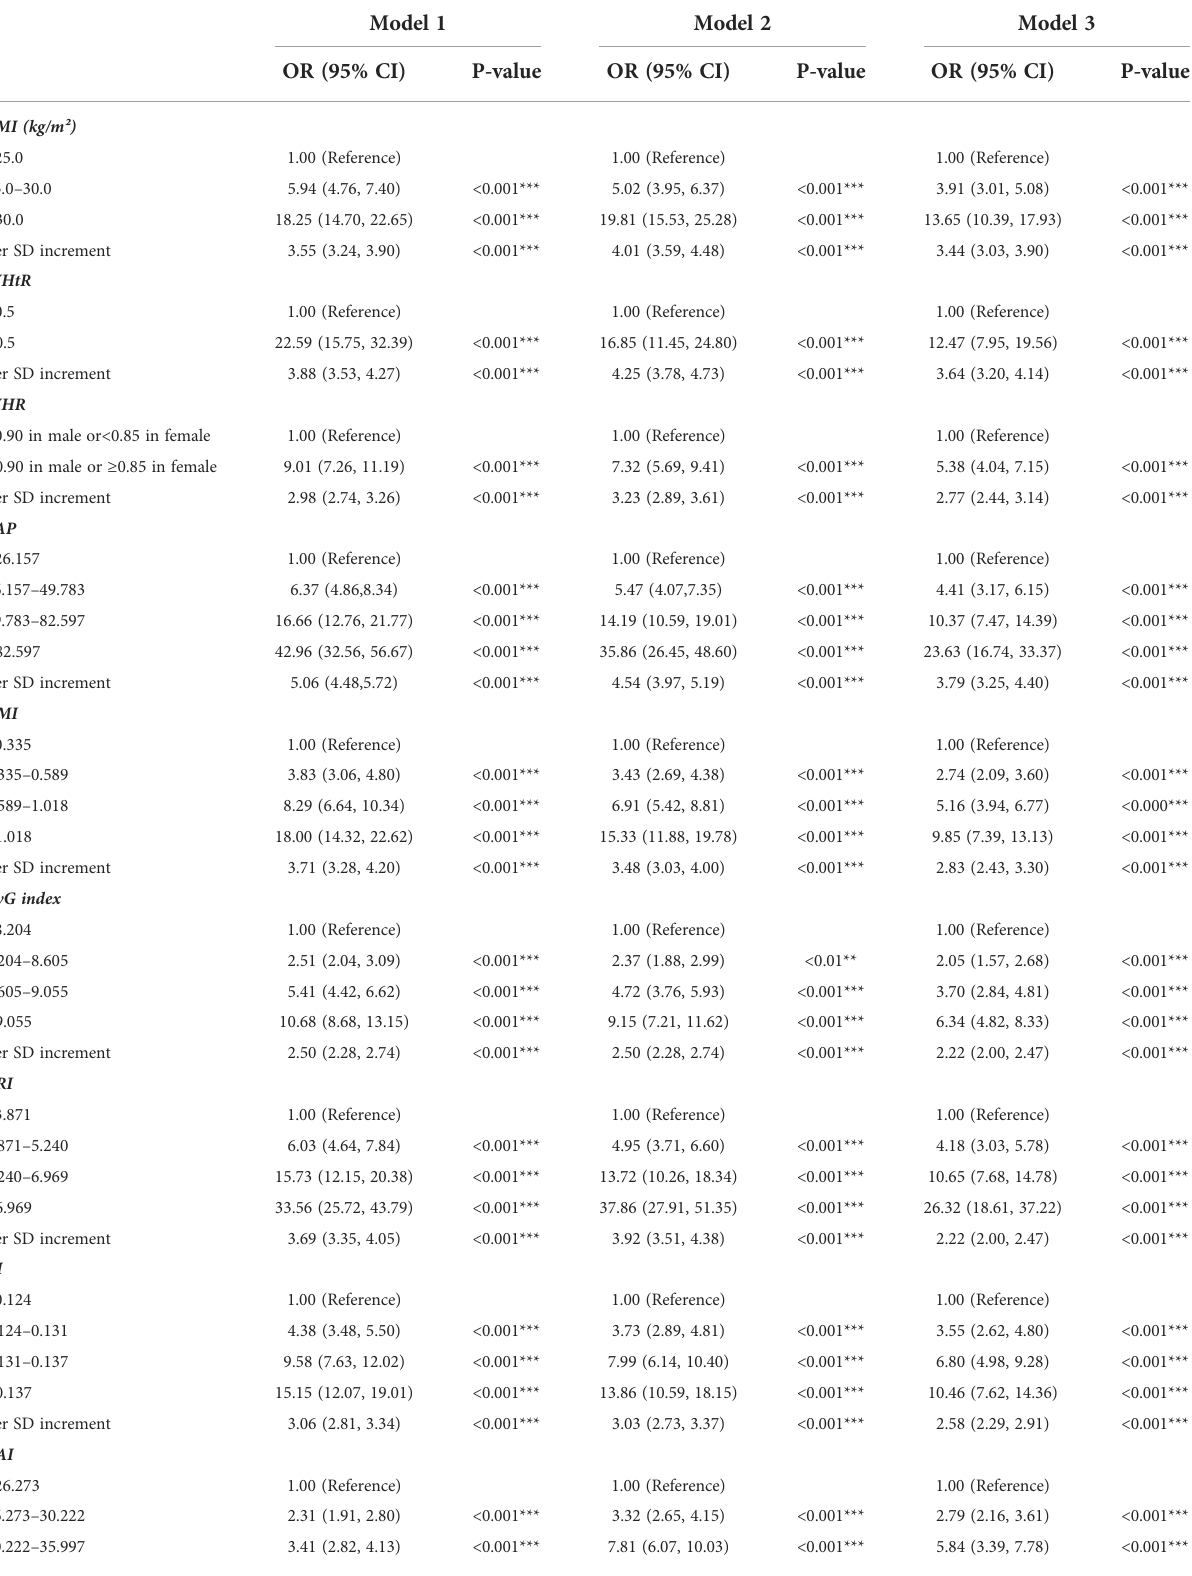
TABLE 3 Multivariate logistic regression models evaluating the associations of anthropometric indices with